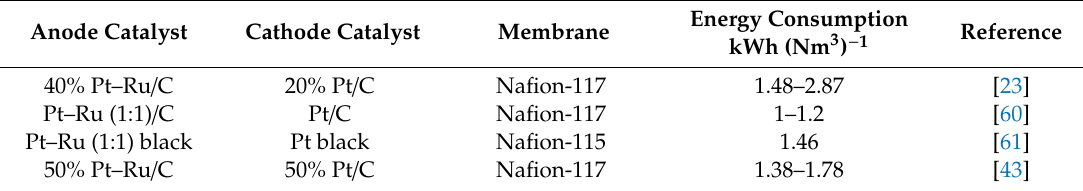
Table 2. Energy consumption of electrolysis based on Pt–Ru / C as an anode catalyst. Anode Catalyst